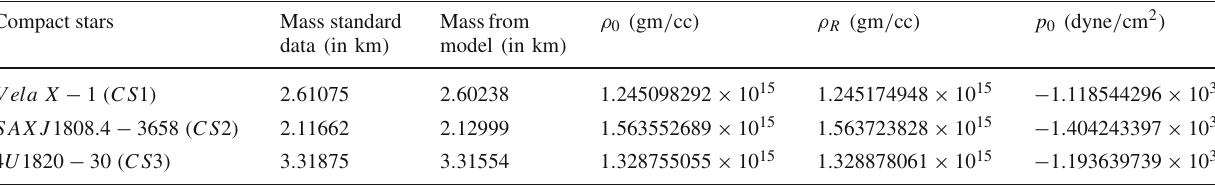
Table 7 Calculated values of mass, energy density and pressure of our model from Table 4 Compact stars Massstandard Massfrom data (in km) model ( in km